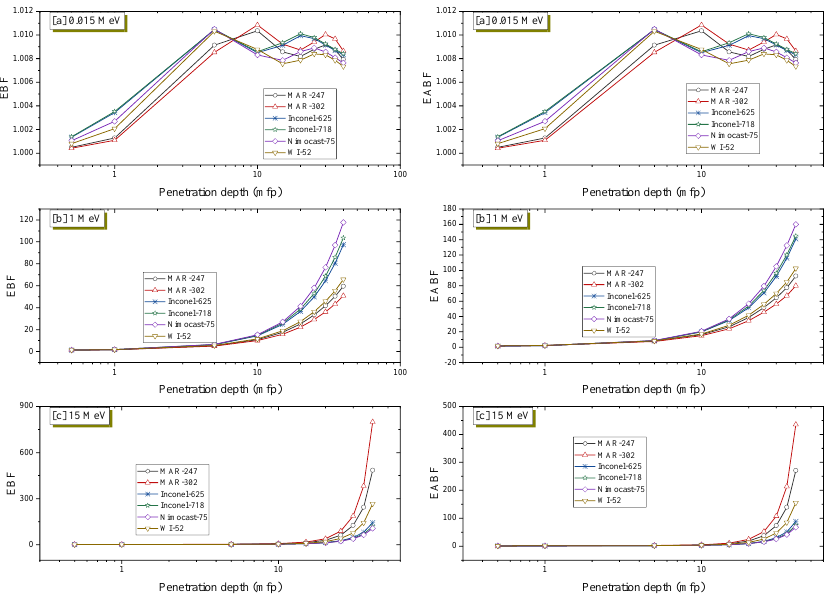
Figure 8. Variation of the buildup factors versus the penetration depth of the studied alloys at some fixed energies: ( a ) 0.015 MeV, ( b ) 1 MeV, ( c ) 15 MeV. Furthermore, the ability of the selected alloys to attenuate fast neutrons was evaluated. The effective removal cross-section R (cm 2 .g −1 ) for fast neutrons was calculated according to Equations (5) and (6) [35]